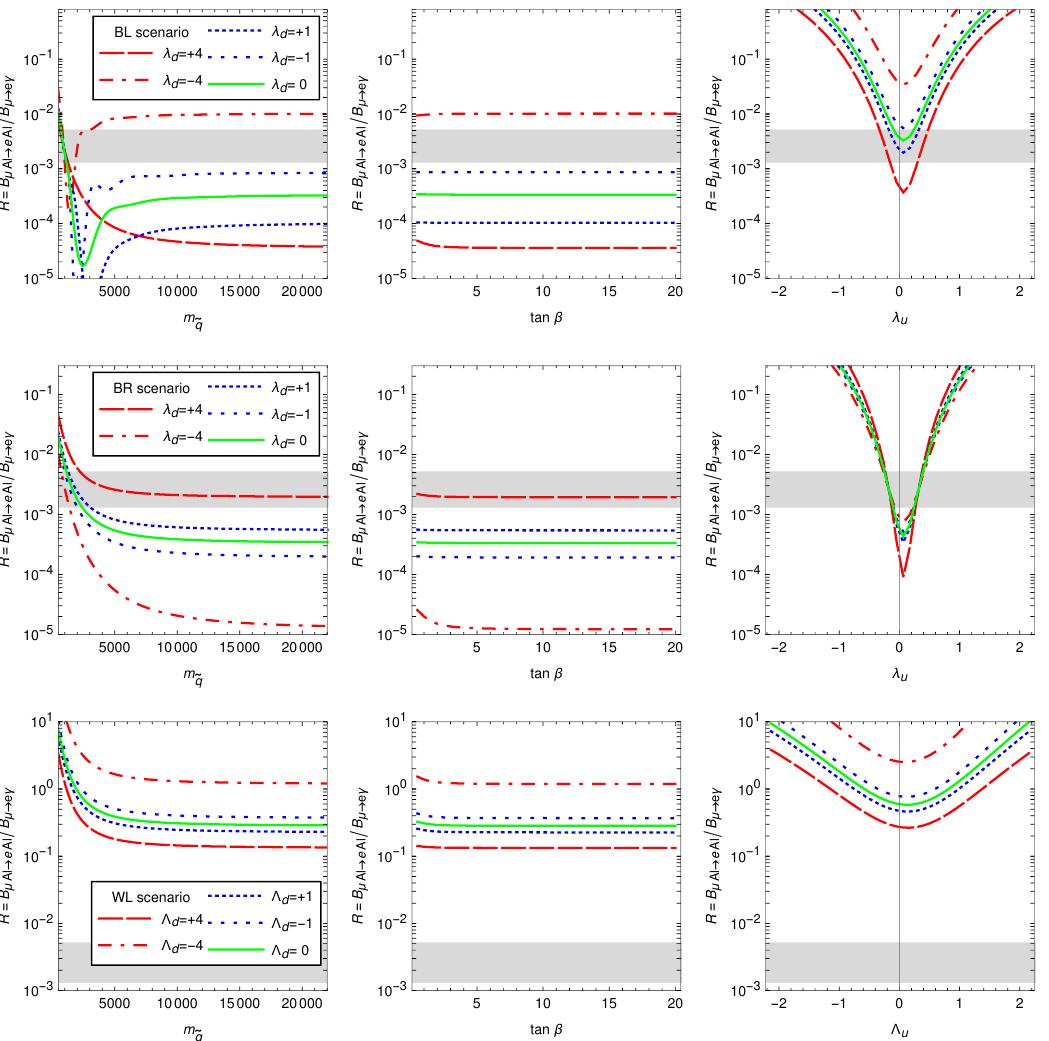
Figure 11. As (cid:12)gure 10, but for the scenarios BL, BR, WL without light (cid:22) d . The plots allow to easily read o(cid:11) under which conditions dipole dominance holds and under which conditions (cid:22) e can be enhanced relative to (cid:22) e(cid:13) . The cases with enhanced ! ! (cid:22) e are very interesting in view of the forthcoming COMET and Mu2e experiments since ! they allow signals in those experiments without violating the MEG limit on (cid:22) e(cid:13) . ! For the discussion we (cid:12)rst focus on the regions of large m ~ q in the squark mass plots in the (cid:12)rst column and large tan (cid:12) in the tan (cid:12) plots in the second column. These regions show the \baseline behaviour" resulting only from the form factors A 1 and A 2 , while the Z - penguin and box diagrams are negligible. The results for large (cid:21) d , (cid:3) d in the BHL, BHR, j j j j WHL scenarios are in the gray region: this corresponds to the expected dipole dominance for light Higgsino mass (cid:22) d and large (cid:21) d , (cid:3) d resulting from the mass insertion diagrams j j j j discussed in section